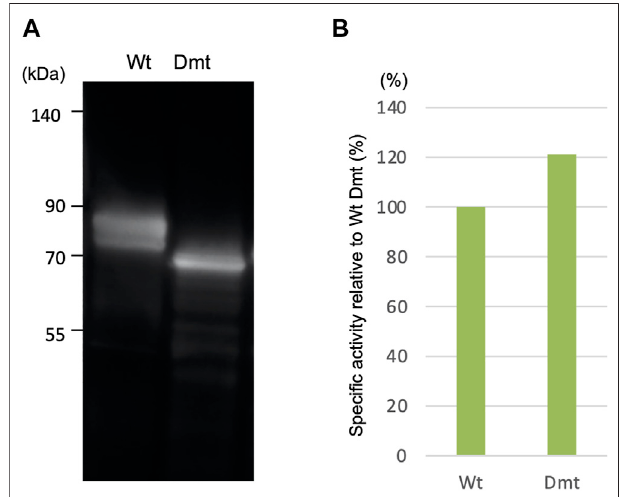
FIGURE 1 | Expression of recombinant wild-type (Wt) and double mutant (Dmt) CLuc EX . (A) Immunoblot analysis of recombinant proteins using anti-CLuc antibody. (B) Relative speci fi c CLuc EX activities in the medium. CLuc EX -speci fi cactivitieswere determined by dividingthe luminescence intensities by the amount of each protein estimated from immunoblot band intensities. The activity of Wt CLuc EX corresponds to 100%. Note that the immunoblot band looks broad due to glycosylation modi fi